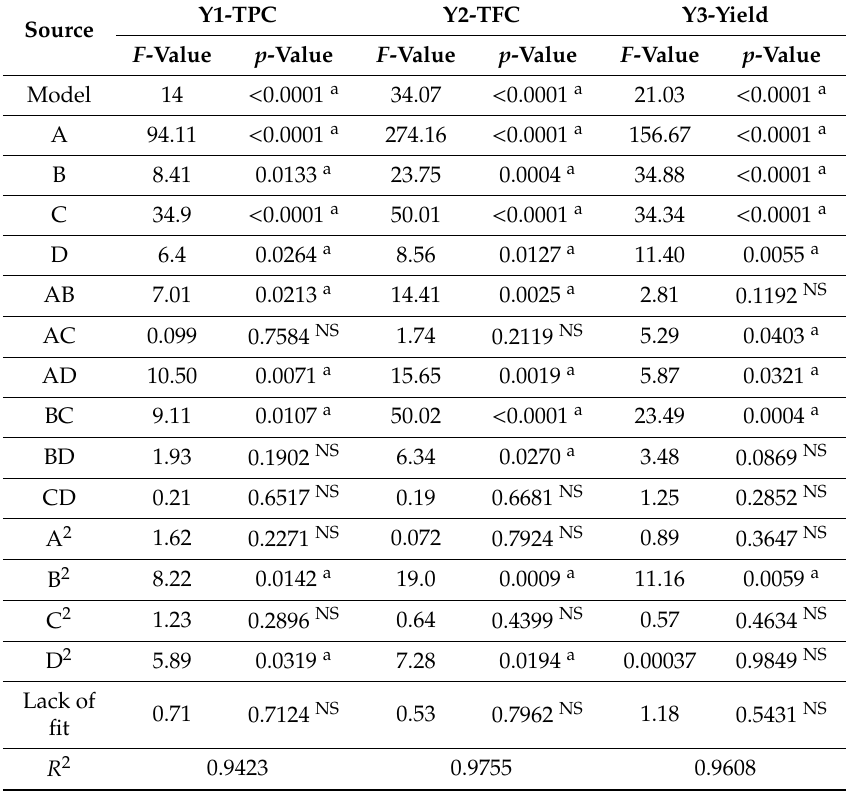
Table 3. Regression coe ffi cient of the predicted second-order polynomial models for total phenolic content, total flavonoid content and